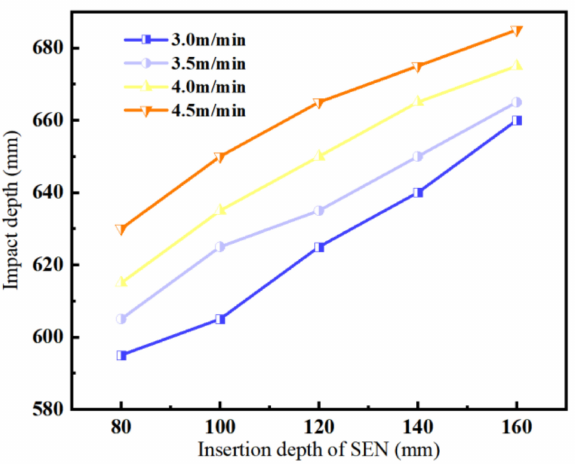
Figure 3. Variation in molten steel impact depth with SEN immersion